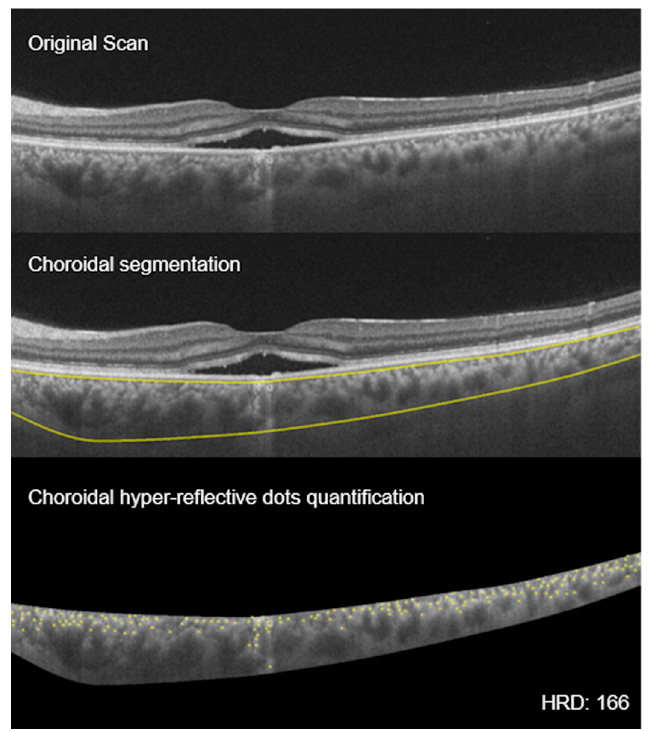
Figure 6. Choroidal hyperreflective dots: montage showing the process of choroidal hyperreflective dots (HRD) calculation. Top scan shows neurosensory detachment in an eye with CSCR; middle scan shows choroidal boundaries using automated algorithm; and bottom scan shows the yellow hyperreflective dots of the choroid (HRD = 166).